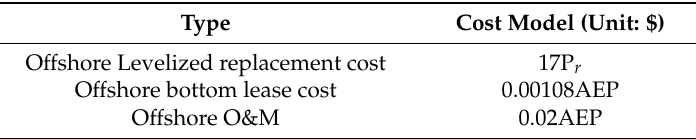
Table 3. Wind turbine annual operation